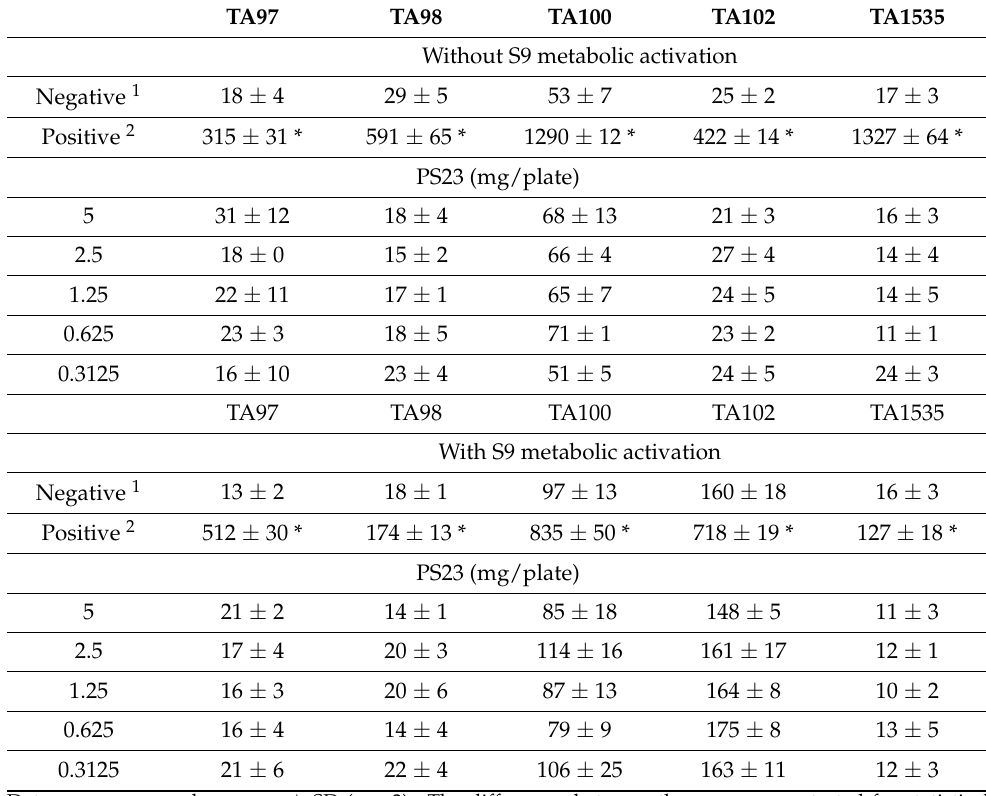
Data were expressed as mean ± SD (n = 3). The differences between the means were tested for statistical significance using one-way ANOVA followed by a Dunnett’s multiple comparison test. Differences between the negative control group and the other groups were considered statistically significant at p < 0.05 (*). 1 Solvent (distilled water) was used as negative control. 2 Positive control: w/ S9: all genotype used 2-aminoanthracene